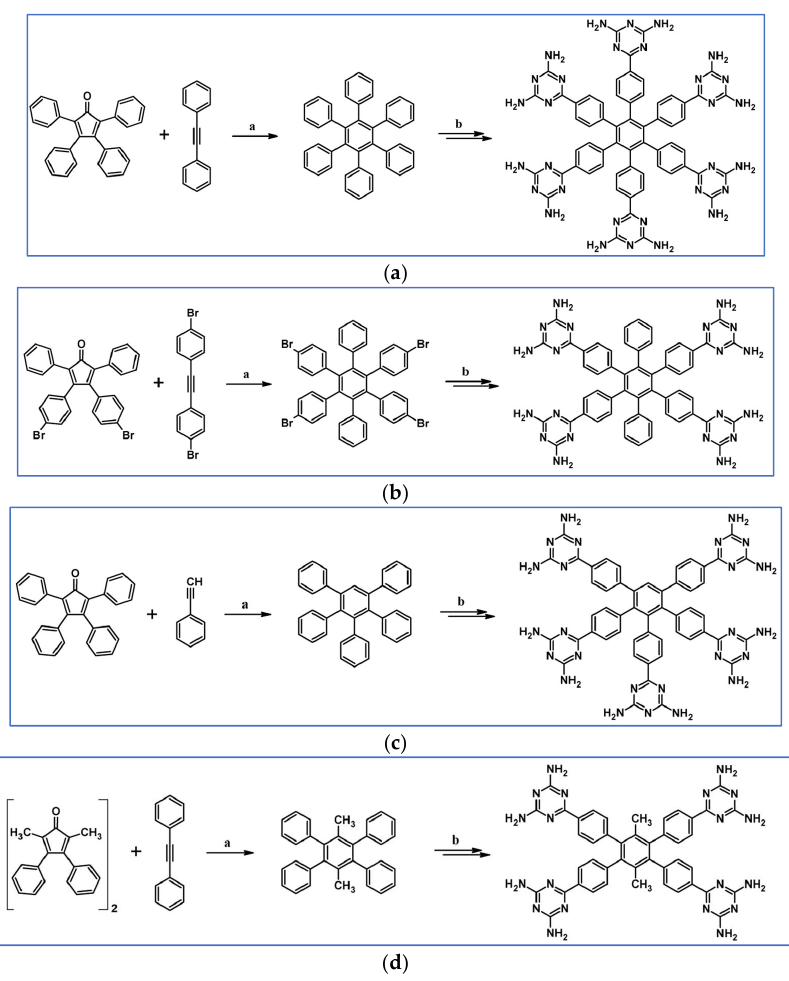
Scheme 60. DA cycloaddition with CO extrusion involved in the synthesis of polysubstituted benzene containing peripheral 2,4-diamino-1,3,5-triazin-6-yl moieties—examples [114]. Reagents and conditions: ( a – d ) a = Ph 2 O, rfx, 0.5–48 h, up to 93% yield; b = next steps, overall yields up to